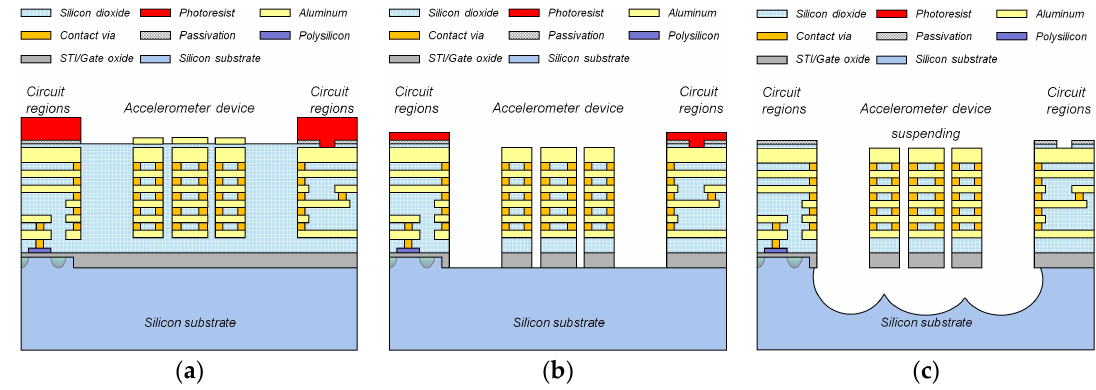
Figure 1. Steps of the CMOS MEMS process: ( a ) the aluminum hard mask and thick photoresist layer after completion of the standard CMOS process; ( b ) anisotropic dry silicon dioxide etching, and ( c ) isotropic dry silicon etching and structural release.